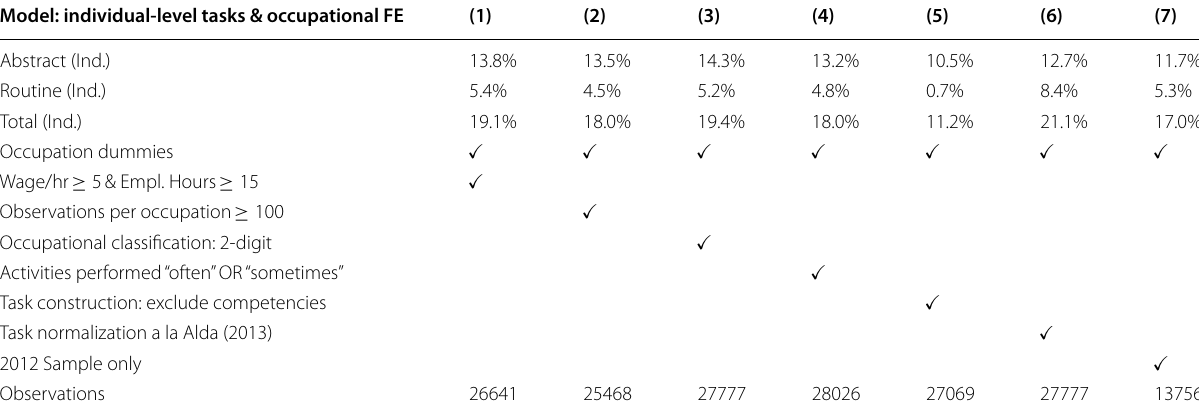
The displayed values represent the unique variation in log wages associated with the task measure of interest, expressed relative to the R-squared of the full model. The output provides robustness checks on a model comprising individual-level and occupational FE, thereby accounting for task specialization within occupations. See Table 8 for reference. I use BIBB/BAuA data that has been collected in 2011–12 and 2017–18, and data from BERUFENET, covering the years 2011–13. For the BIBB/ BAuA data, see Hall et al. (2020b) and (Hall et al. (2020a), respectively. For the BERUFENET data, see Dengler et al.